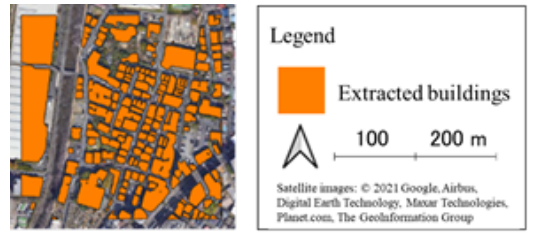
Figure 4 . Example of region where the IoU is high